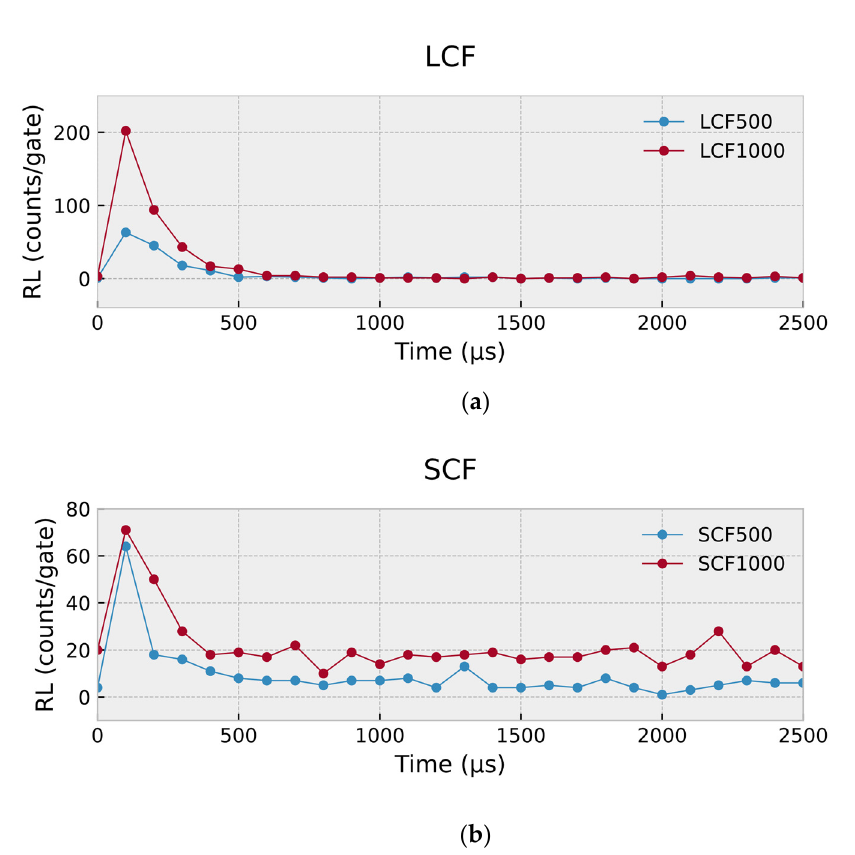
Figure 8. RL yield per gating time of 100 µ s during a single pulse for ( a ) LCF samples ( b ) SCF samples at 590 MU/min.